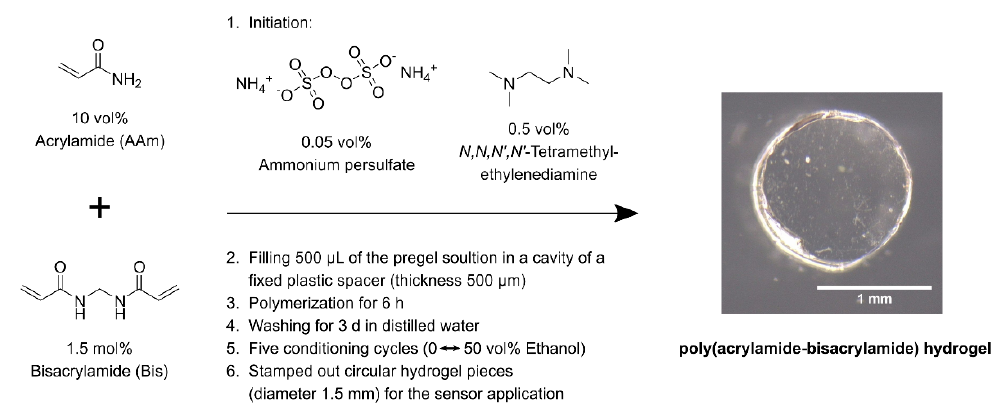
Figure 1. Synthesis of alcohol-sensitive poly(acrylamide-bisacrylamide) hydrogels and their preparation for the application in a piezoresistive pressure